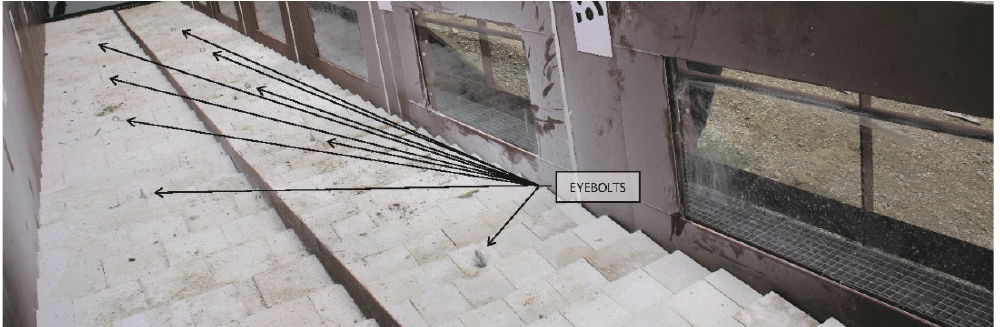
Figure 9. Picture of the intermediate wall dividing the two areas with different WSB sizes and eye- bolts installed on some of the WSBs for block-extraction tests.